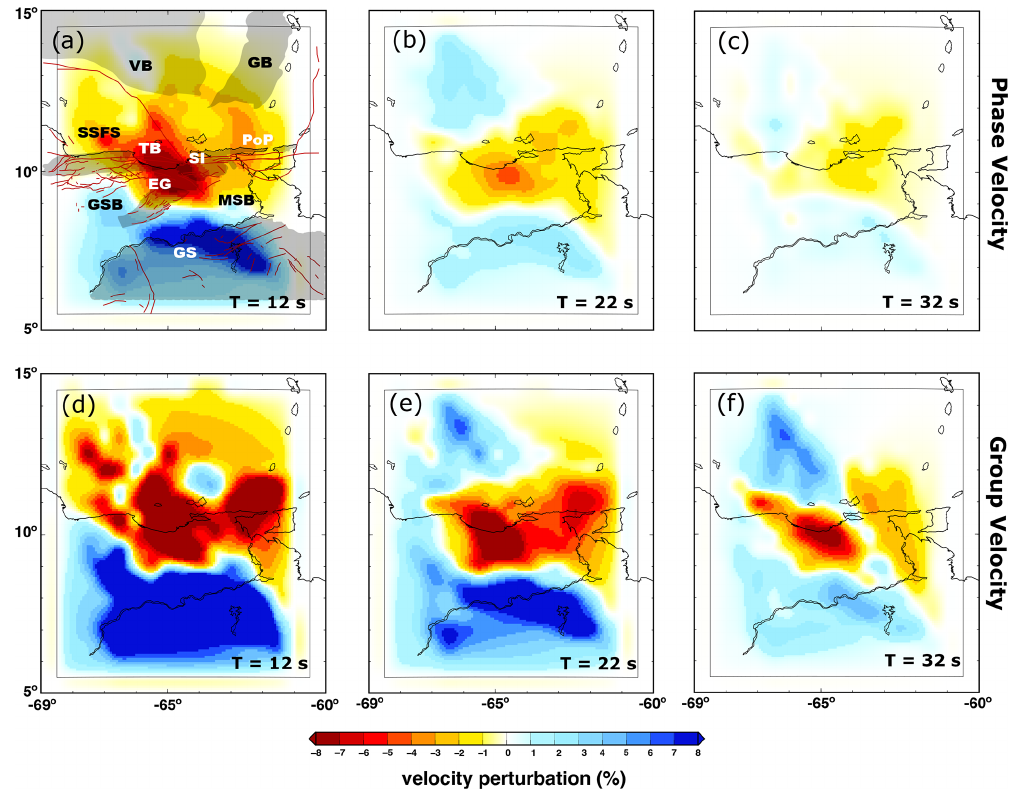
Figure 5. Rayleigh-wave phase (a–c) and group velocity (d–f) maps for wave periods of T 12, 22 and 32s. The gray box denotes the area with reliable measurements based on ray-path coverage. In red we show active faults as presented by Audemard et al. (2006). Abbreviations are VB (Venezuela Basin), GS (Guiana Shield), MSB (Maturín sub-basin), GSB (Guarico sub-basin), SI (Serrania del Interior), EG (Espino Graben), TB (Turtle Island–Barcelona Bay), PoP (Peninsula of Paria) and SSFS (San Sebastian Fault System). VB, GB, SSFS, EG, SI, PoP and GS regions are highlighted with shaded